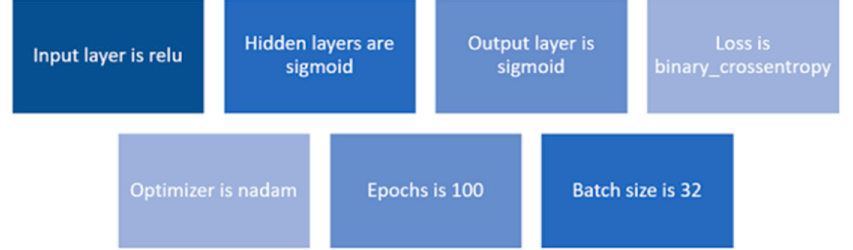
Figure 5. Optimal parameters.